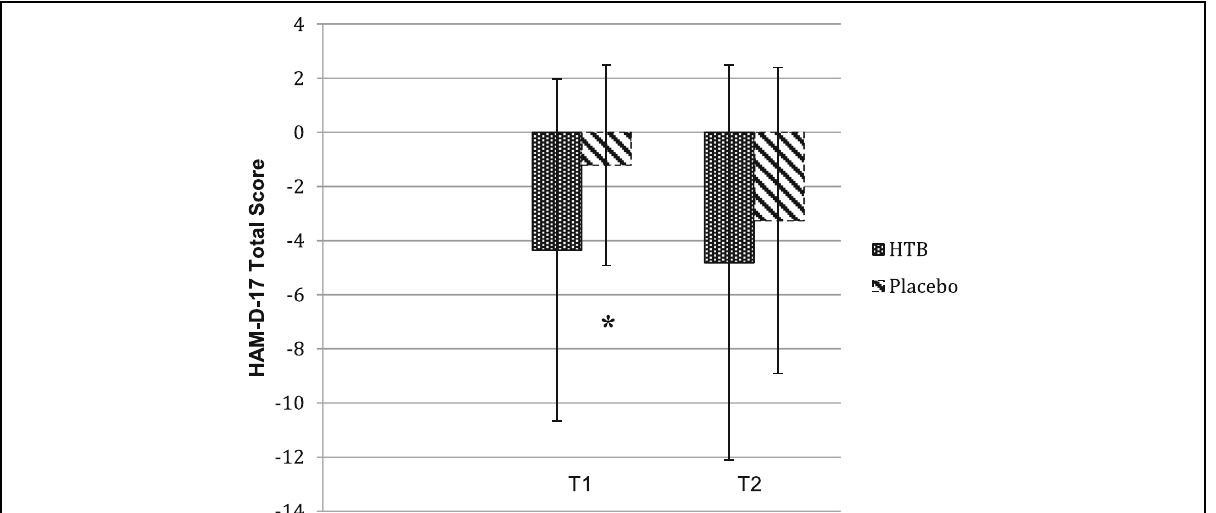
Fig. 2 Change scores in the 17-Item Hamilton Scale for Depression (HAM-D-17) from baseline (T0) in the hyperthermic bath group compared to the placebo group (intention-to-treat population; a N =36). T1 indicates after 2 weeks of treatment (4 hyperthermic baths (HTB) vs sham intervention with green light (placebo); T2, 4 weeks after discontinuation of treatment (follow-up). a The intention-to-treat analysis used last-observation-carried-forward.- Error bars indicate standard deviation.* P =